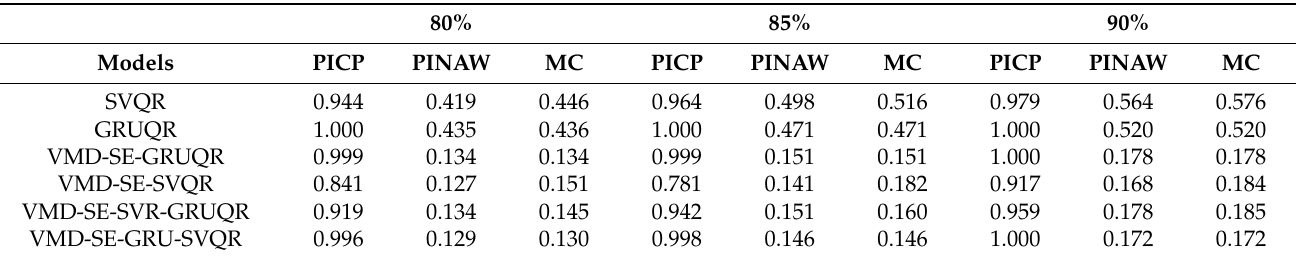
Table 8. Averages of the evaluation metrics.